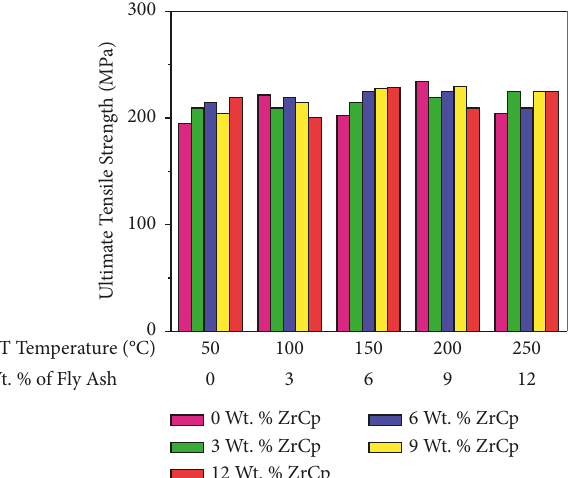
Figure 2: Ultimate tensile strength for variant wt.%.